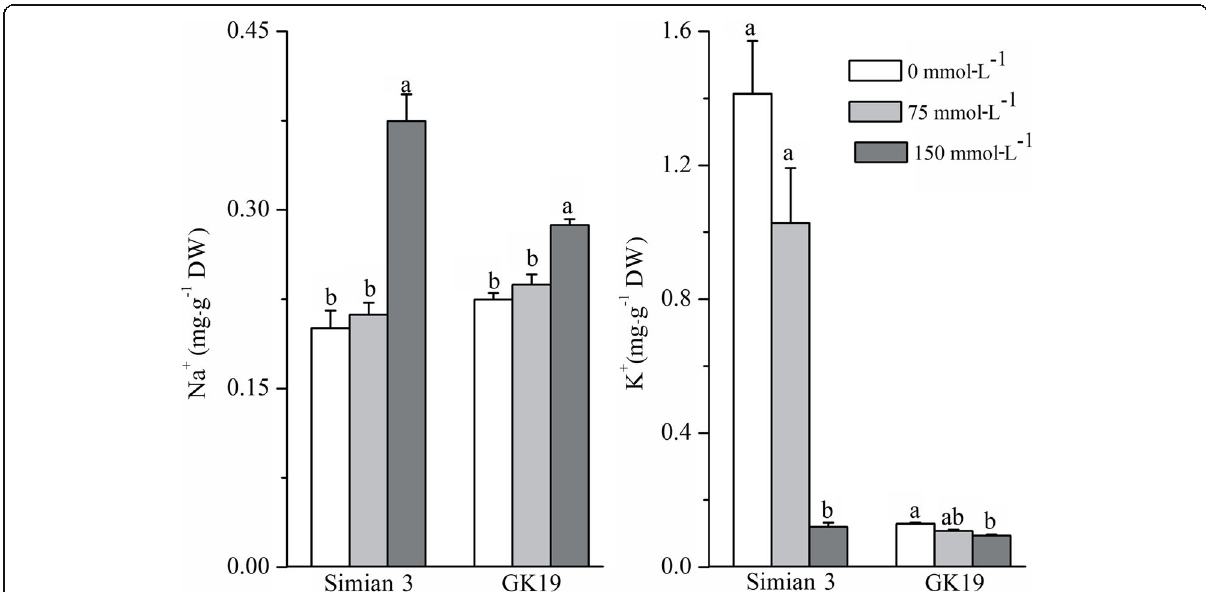
Fig. 2 Effects of NaCl stress on Na and K in GK19 and Simian 3. Mean ± (SE); Significant difference in lowercase letters at 0.05 level between NaCl stress treatments